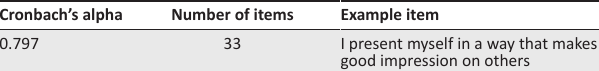
TABLE 1: Cronbach’s reliability